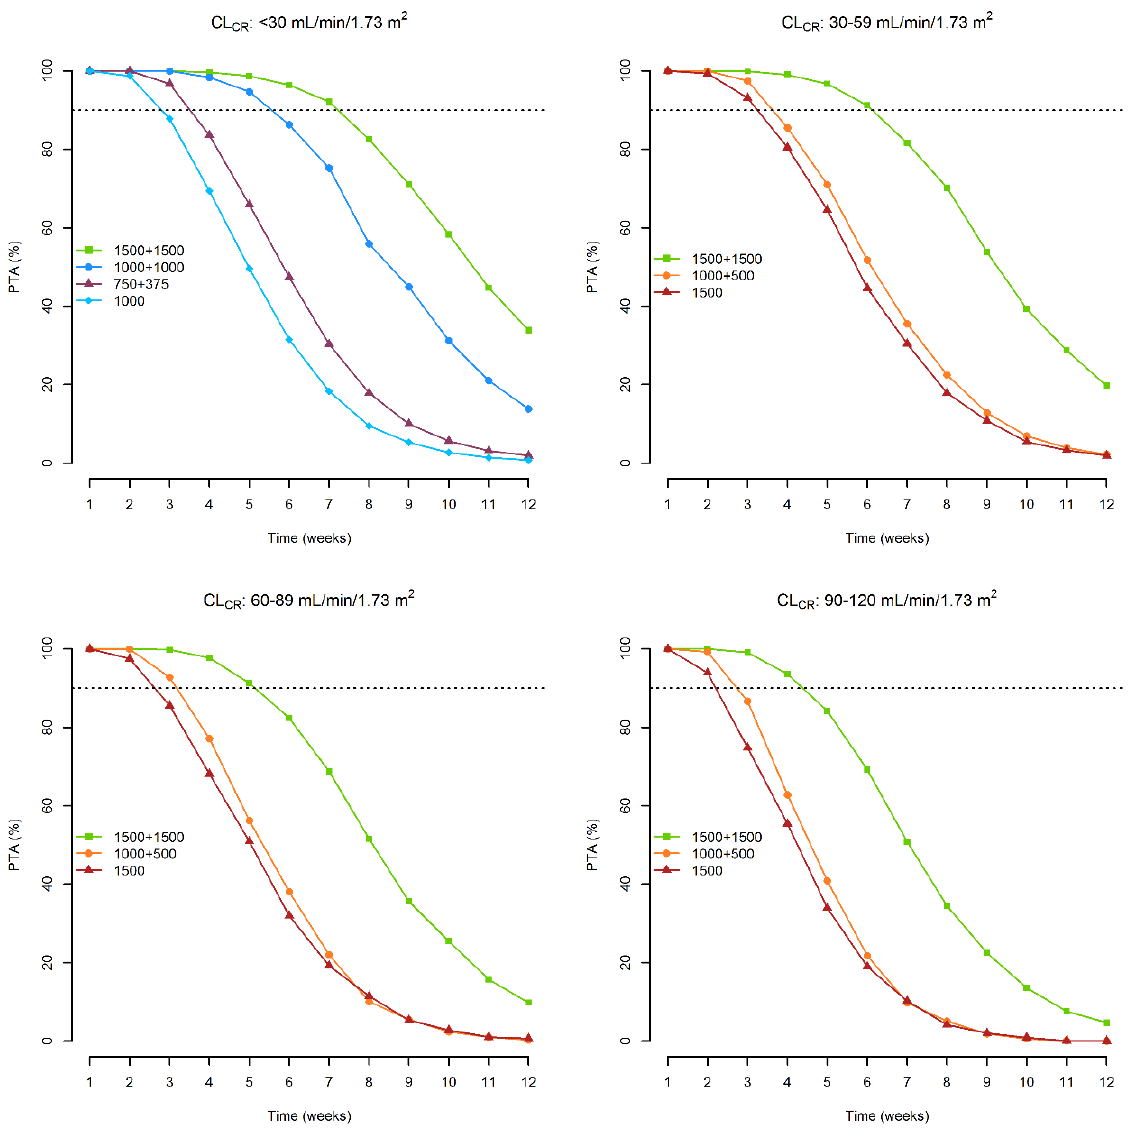
Figure 3. Probability of attaining a plasma concentration ≥ 8.04 mg/L over time associated with the dosages of 1500 mg on day 1, 1000 mg on day 1 + 500 mg on day 8 and 1500 mg on day 1 + 1500 mg on day 8, according to different classes of renal function. Dashed lines refer to a probability ≥90%.